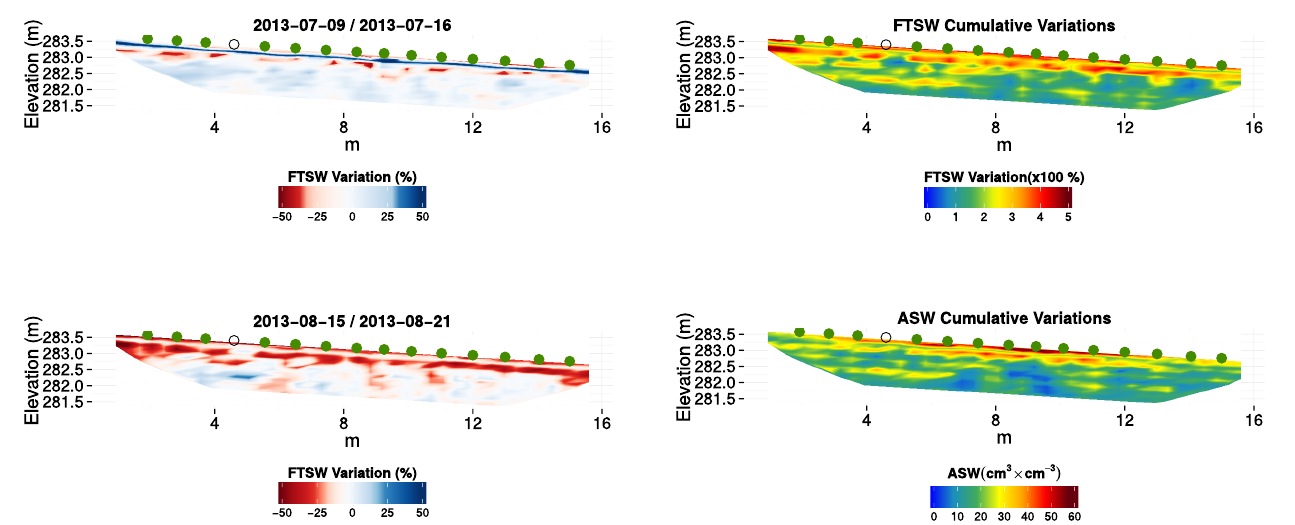
Figure 3. Variations in FTSW between two periods. White colour- ing is mapped to the error associated with the computation of the difference; further explanation can be found in the text. Green-filled dots represent fully developed plants and empty dots represent very young plants (1 year).